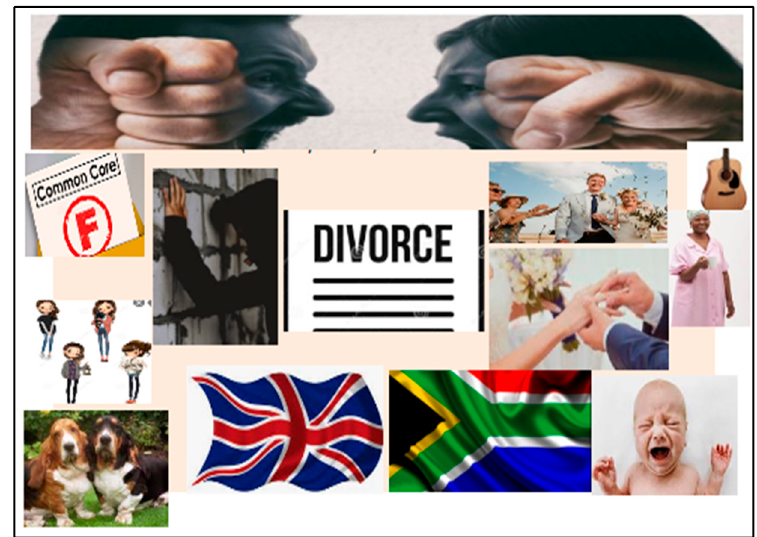
Figure 10. Diana’s adolescent phase.